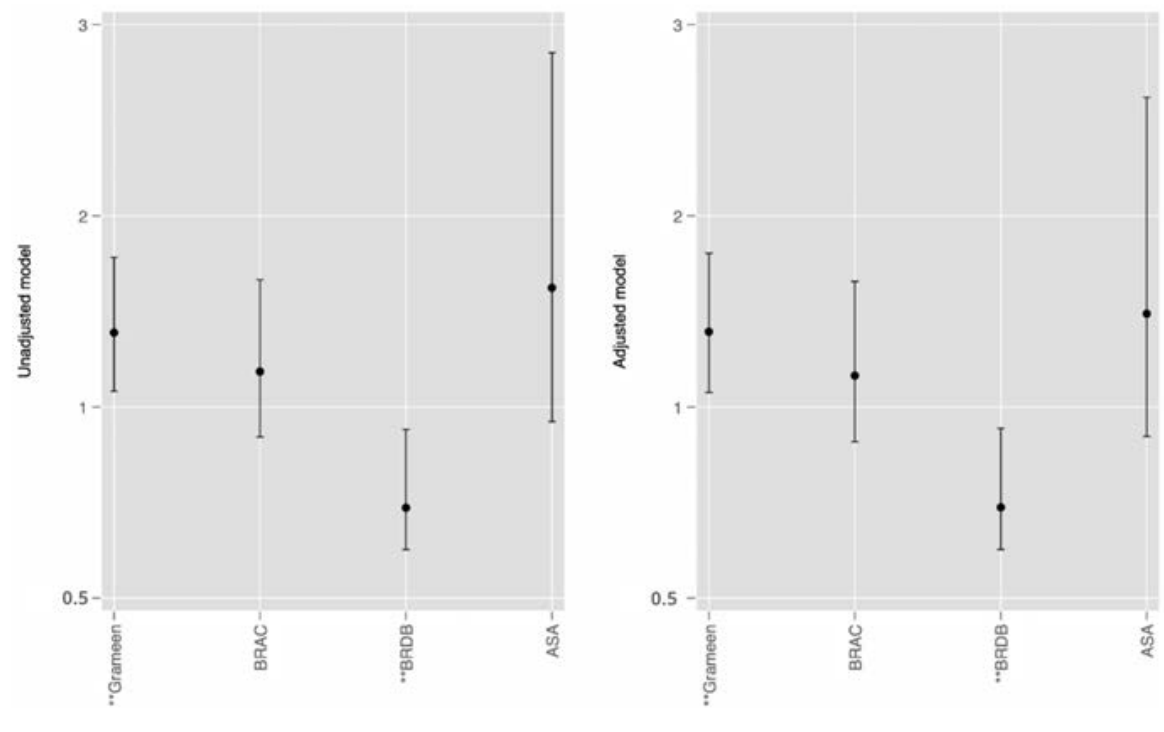
Figure 2. Association between MC membership and health autonomy (BDHS 2004).[21]